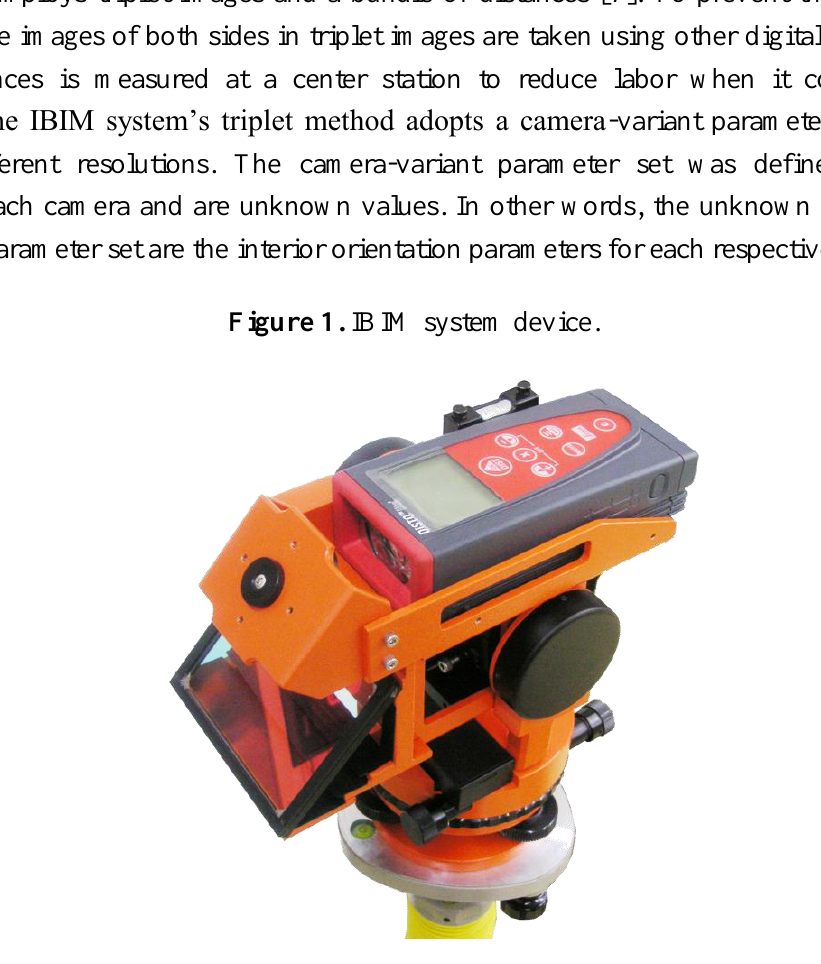
Figure 2. Configuration of the IBIM system